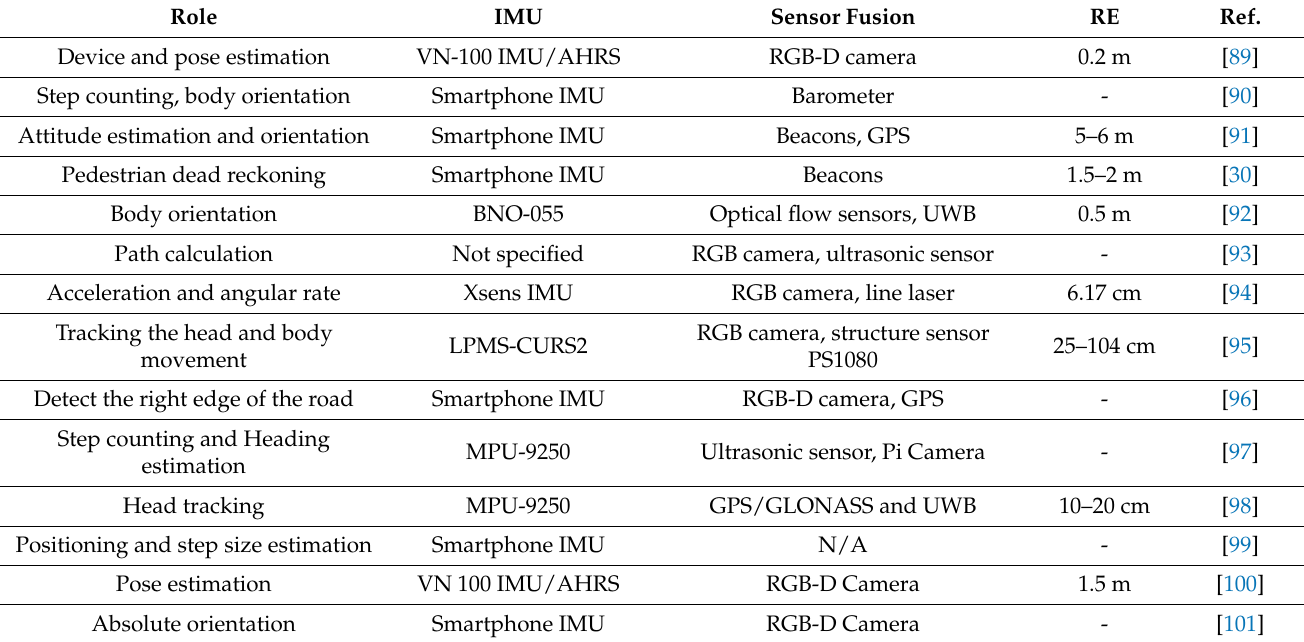
Table 4. Summary reviewed articles in the accelerometer, gyroscope, and magnetometer fusion